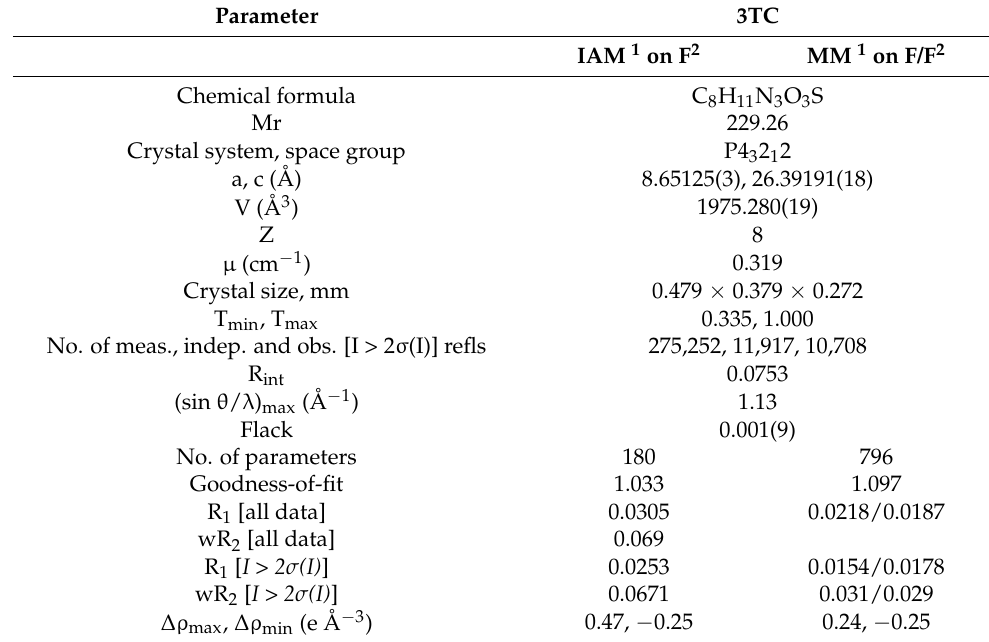
Table 1. Details of experiment and refinement of the tetragonal polymorph II of Lamivudine